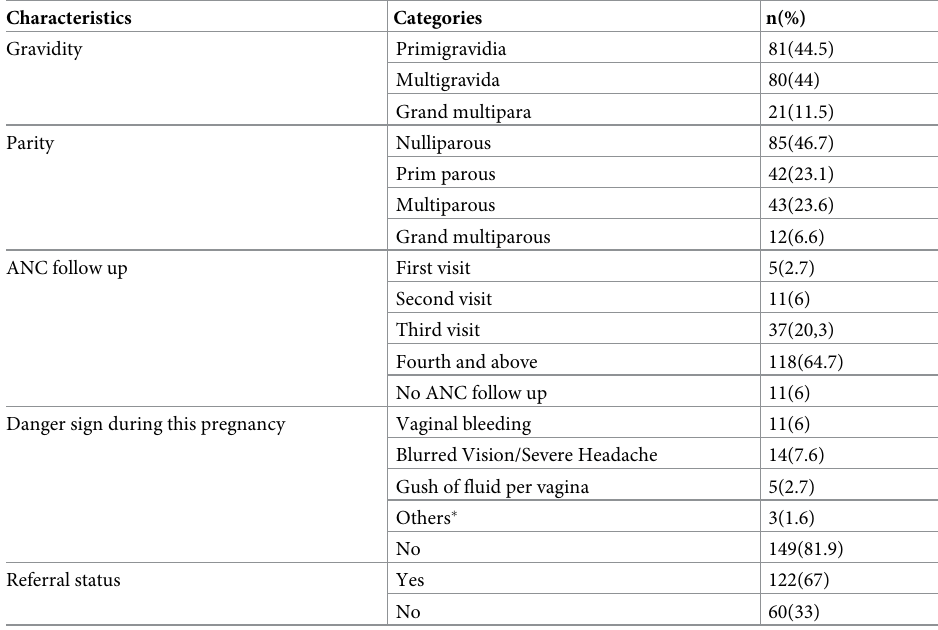
Table 2. Obstetrical characteristics of respondents in Bahir Dar City Public Hospitals, Ethiopia, 2020 (n = 182).